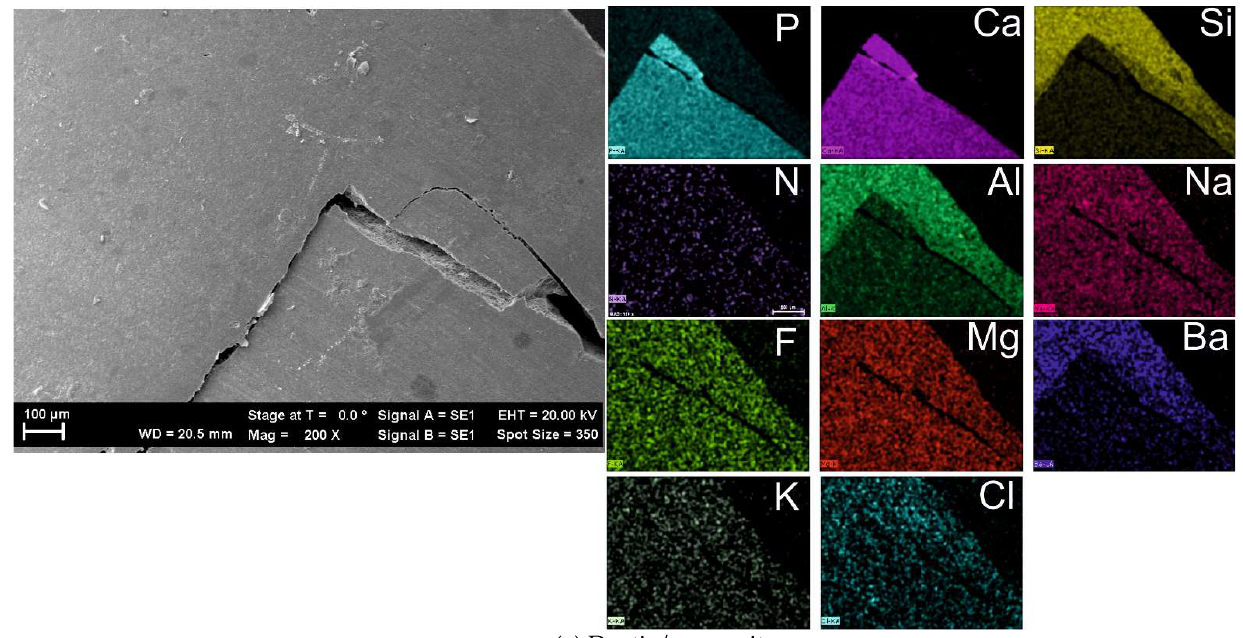
Figure 1. SEM micrographs of the samples: ( a ) Sample 1-the microcomposite, seen in the middle of the section area; ( b ) Sample 1-the side facing the curing lamp; ( c ) Sample 1-the side opposite to the curing lamp; ( d ) Sample 2-the nanocomposite, in the middle of the section area; ( e ) Sample 2-the side facing the curing lamp; ( f ) Sample 2-the side opposite to the curing lamp.